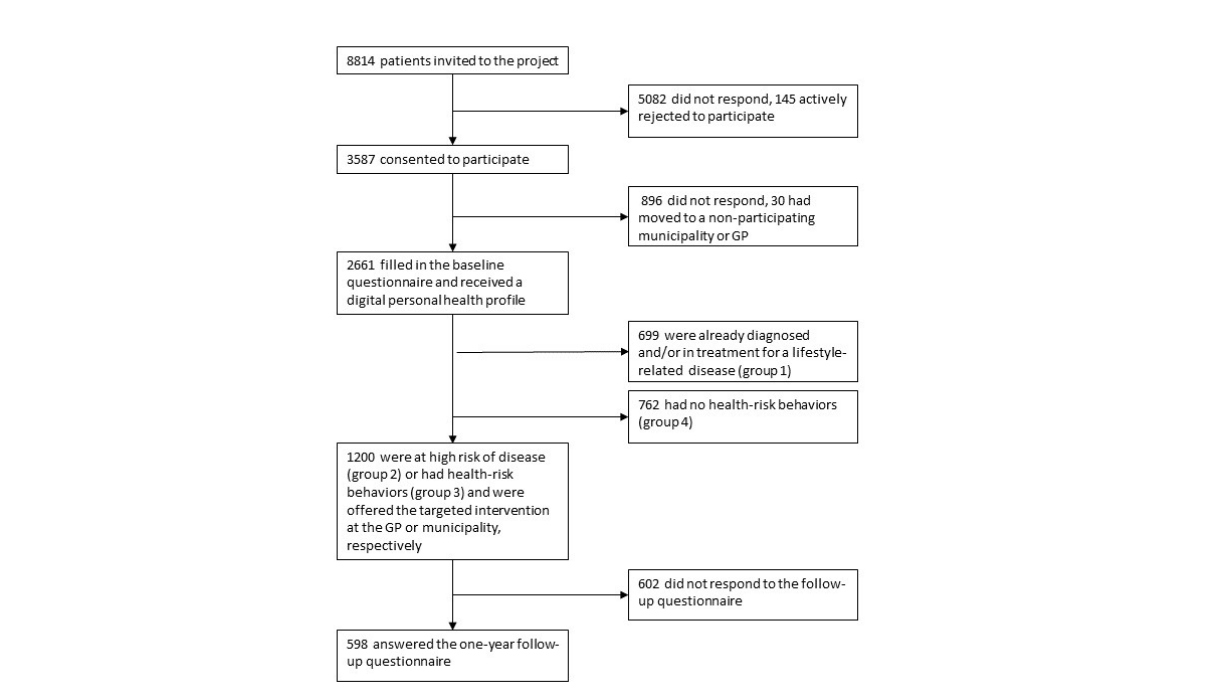
Figure 1. Flowchart of the TOF pilot